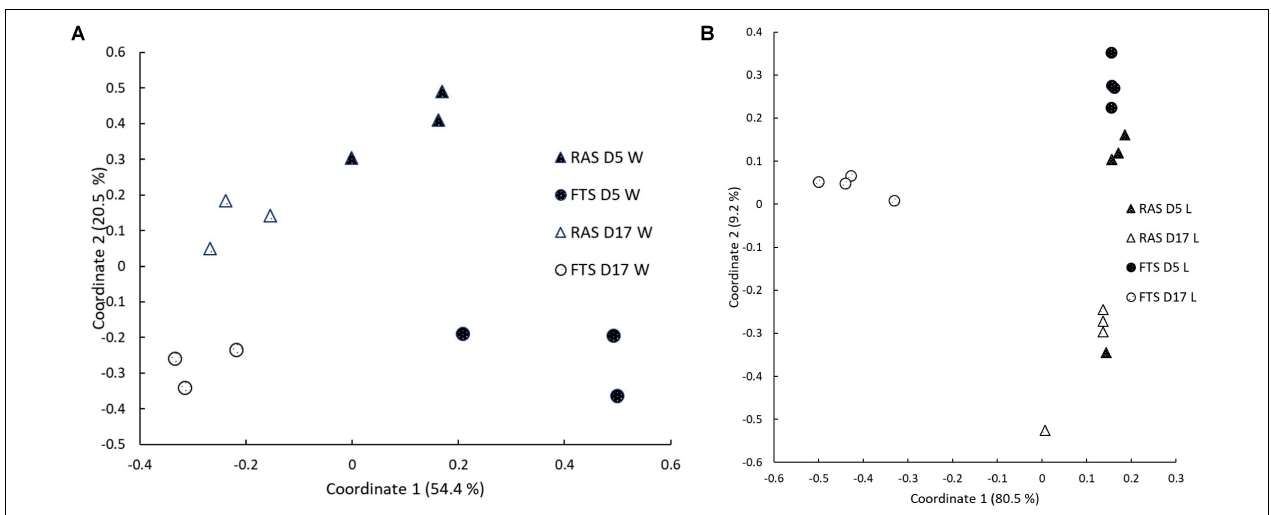
FIGURE 2 | Principal coordinates (PCoA) plot based on Bray–Curtis similarities based on DGGE data for (A) water microbiota (W) and (B) larval microbiota (L). Both plots show samples taken from RAS and FTS at 5 (D5) and 17 (D17) dph.